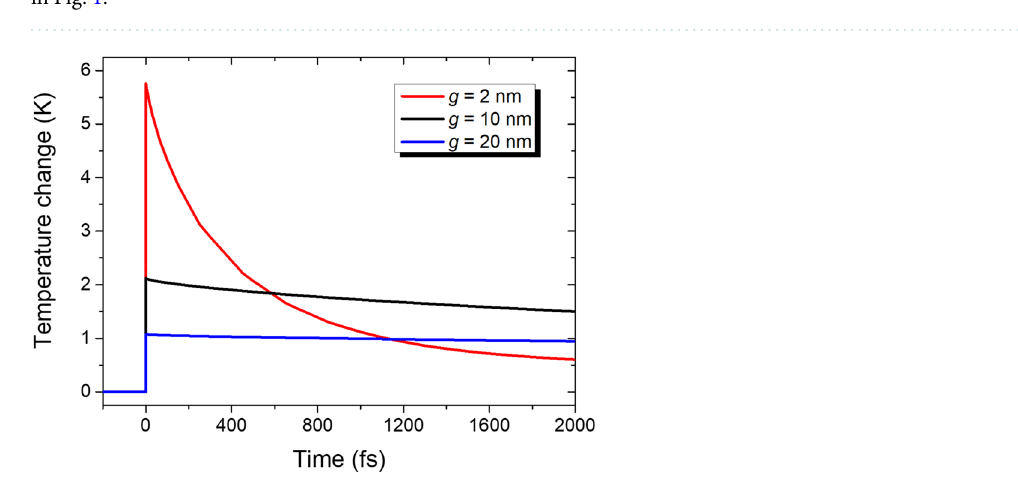
Figure 4. Temperature changes of the VO 2 gap under the 5 nW/μm 2 LWIR irradiation ( a ) for various rod lengths l from 2.0 to 2.8 μm and ( b ) for various gap widths g from 2 to 20 nm. Other parameters are the same as in Fig. 1.